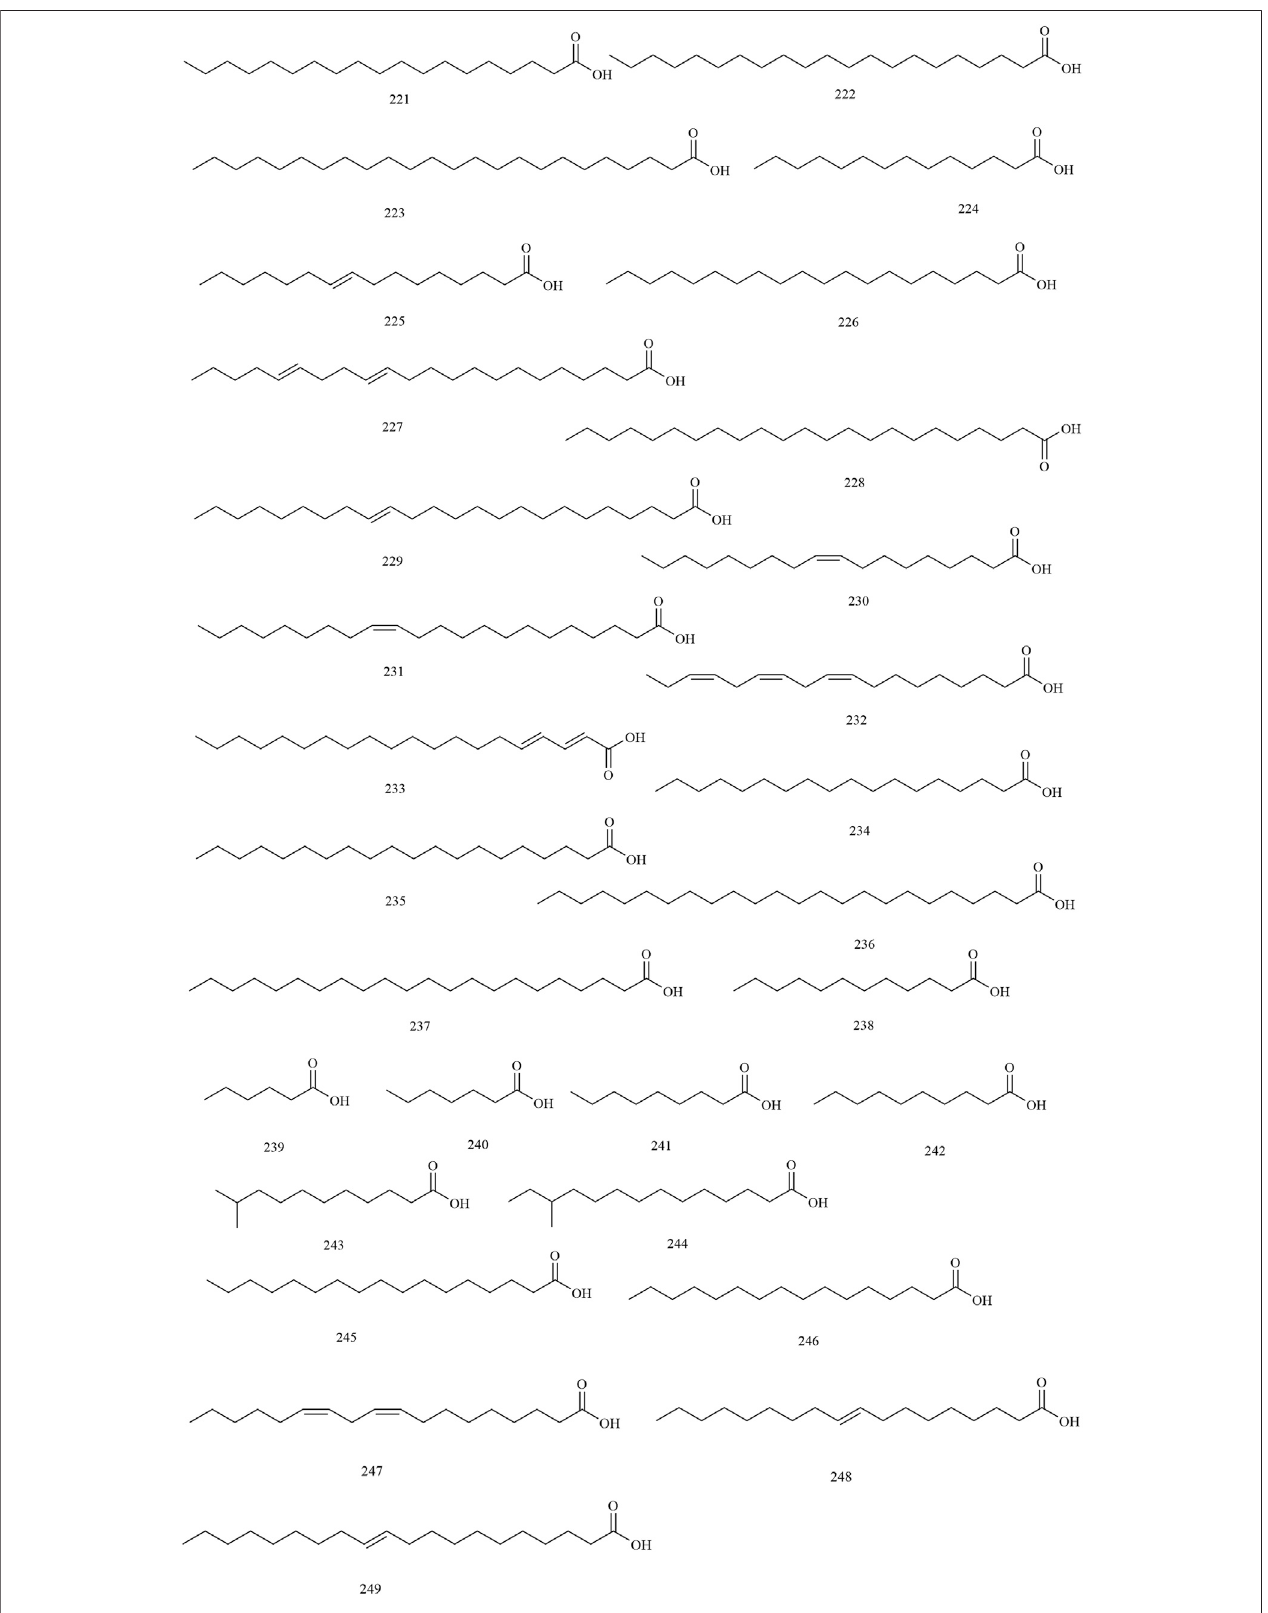
FIGURE 7 | Structures of fatty acid compounds in X. sorbifolium .